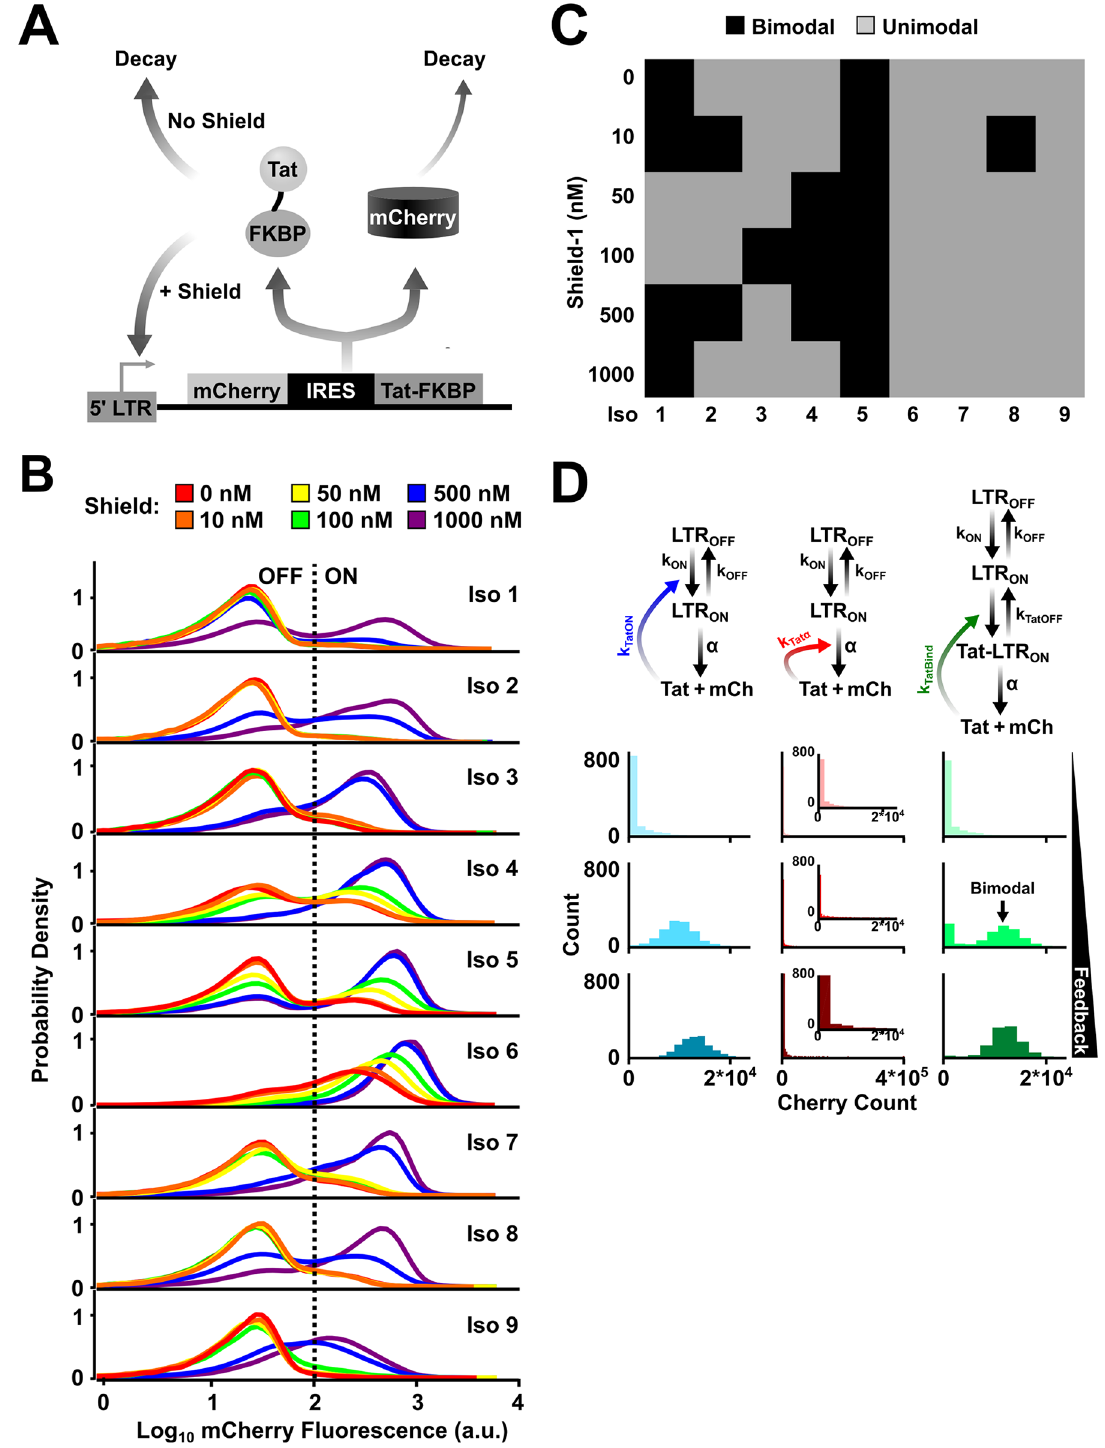
Fig 3. Positive-feedback strength controls whether the expression distribution is unimodal or bimodal in HIV. (A) Schematic of the LTR-mCherry-IRES-Tat-FKBP closed-loop, positive-feedback circuit. The transactivatorof transcription (Tat) stability is tuned through the additionof Shield-1to alter Tat feedbackstrength (i.e., loop transmission) (S9 Fig). (B) Flow cytometry histograms showingbimodaldistributionfor 9 isoclonalcell lines exposedto variousconcentrations of Shield-1.A fraction of isoclonescan naturallygeneratebimodaldistributions with low feedbackstrength (e.g., red [0 nM Shield-1]), but